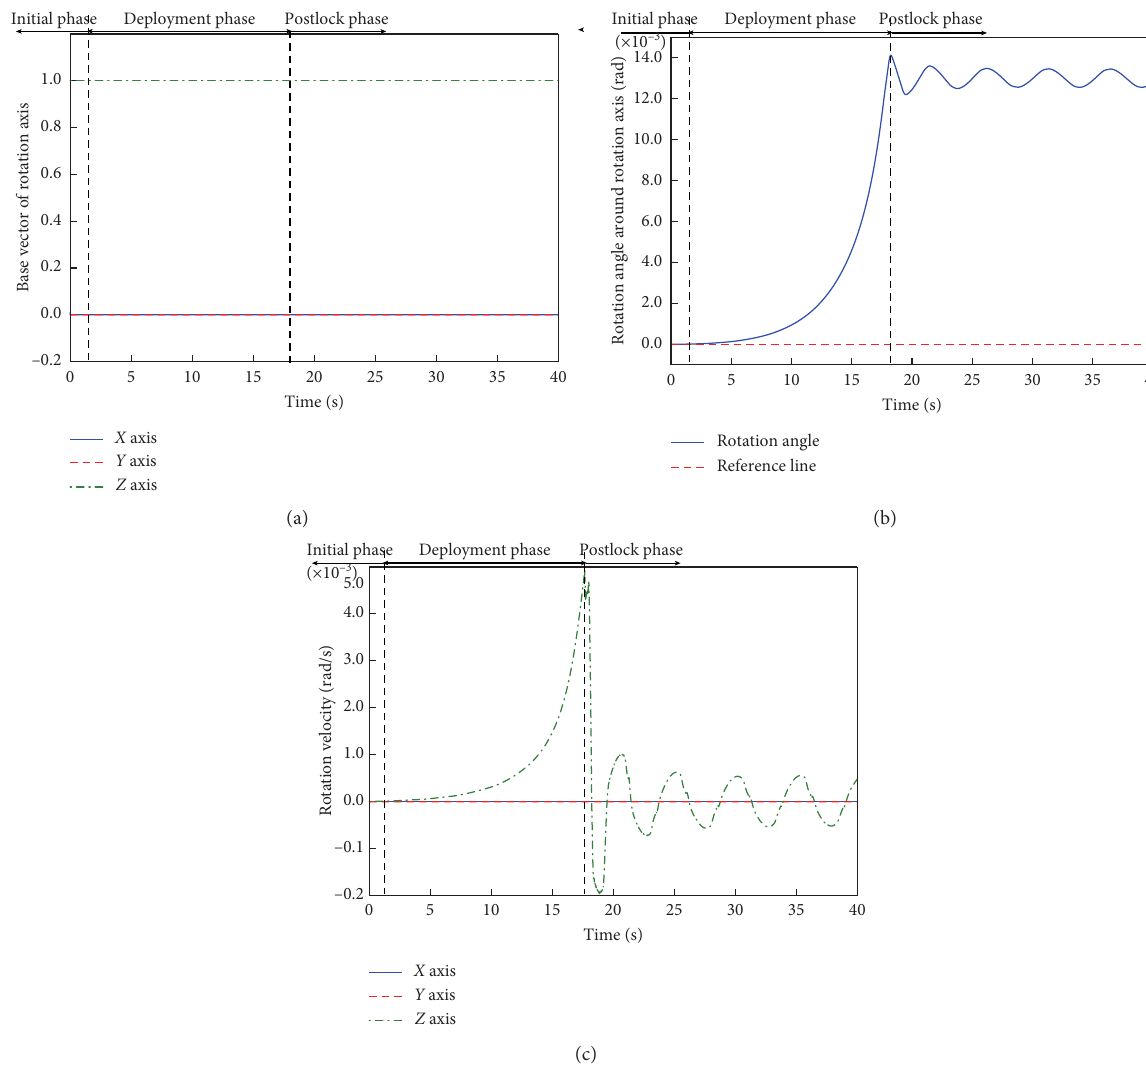
Figure 15: Attitude responses of the spacecraft main body. Table 2: Parameters of the PD controller in the simulation cases. Group